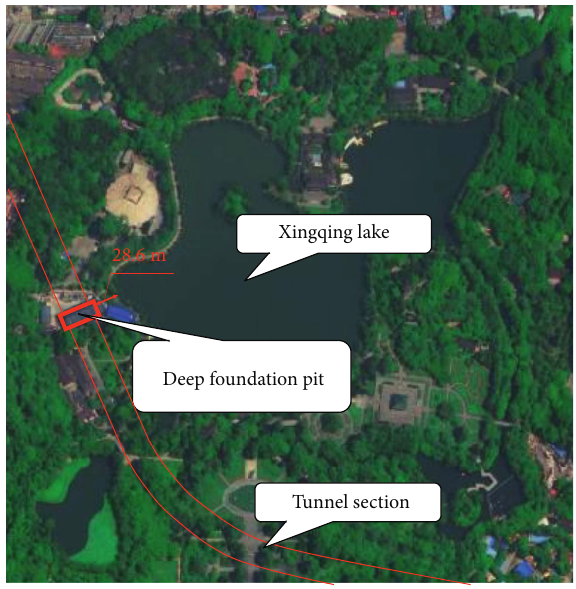
Figure 2: The location of the foundation